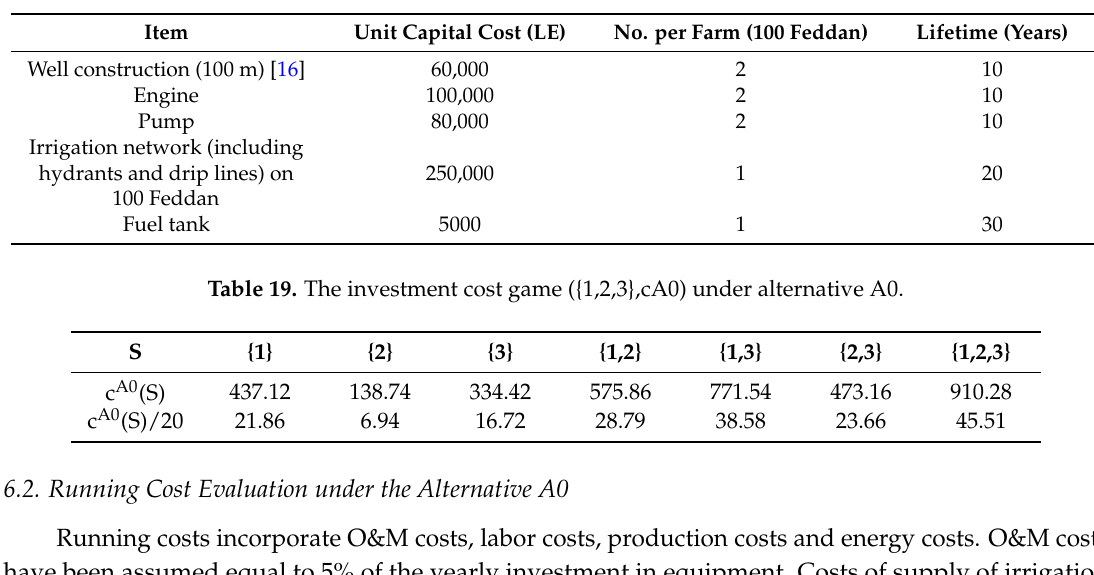
Table 18. Cost of pumping and irrigation network.